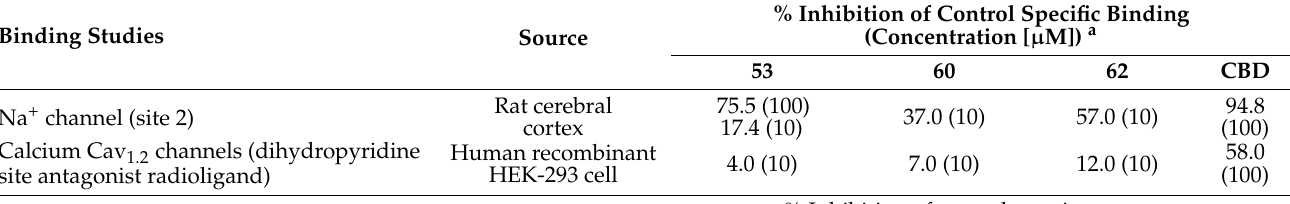
Table 4. In vitro binding and functional assays for 53 , 60 , 62 , and CBD